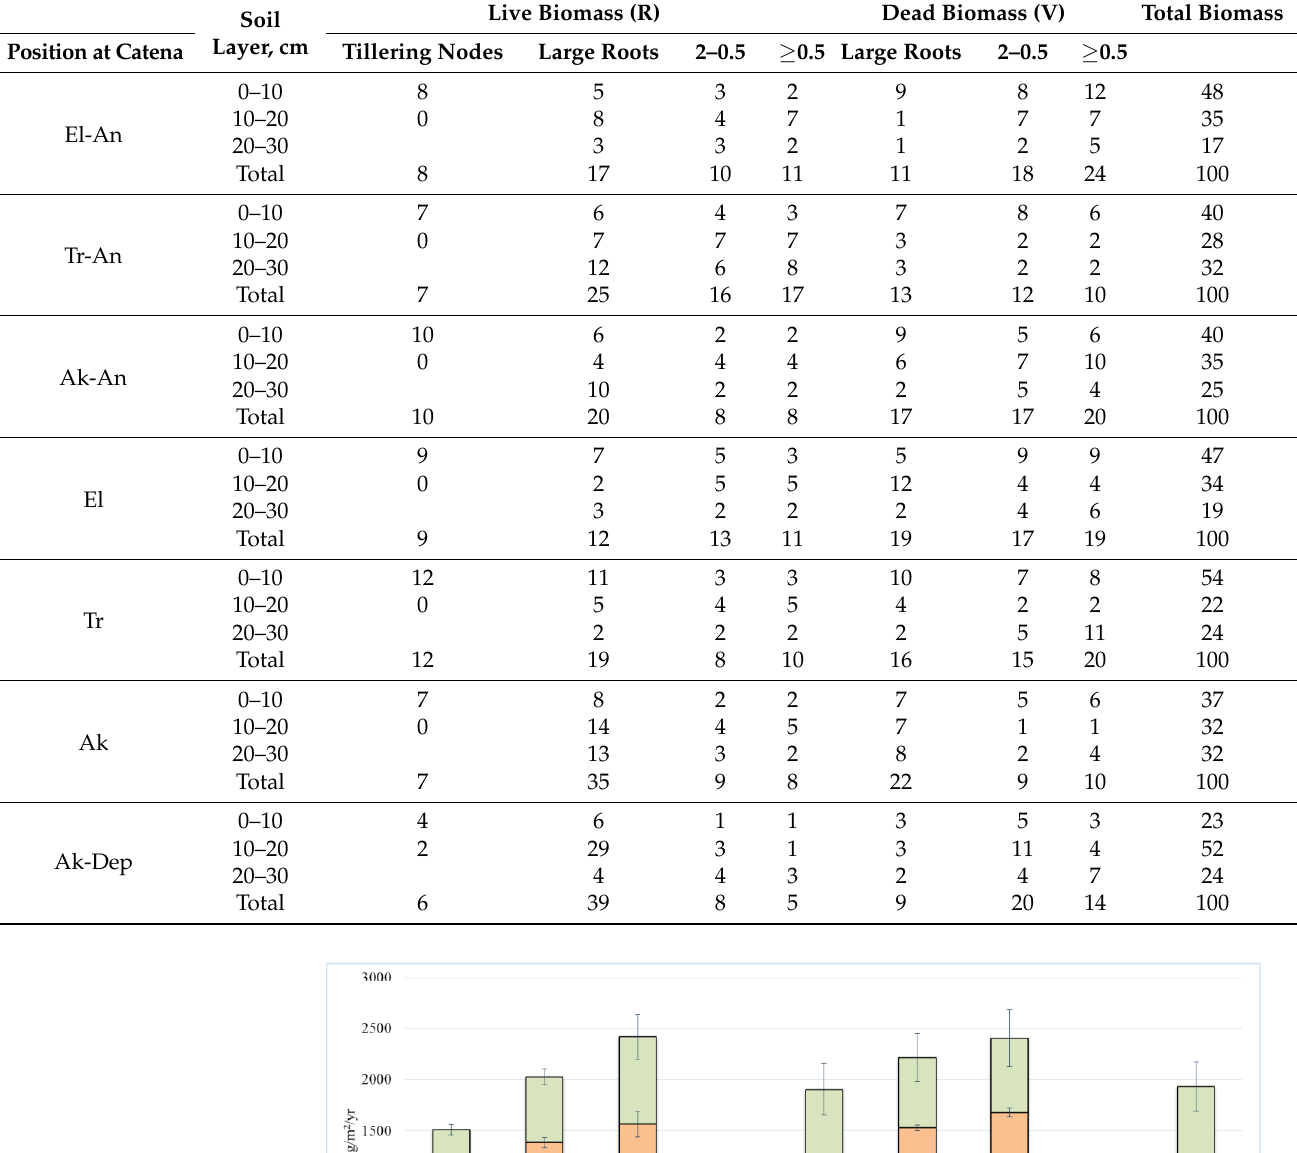
Table 2. Distribution of below-ground biomass by depth and its fractions at the catena, %.